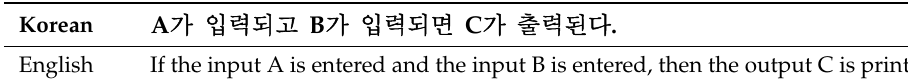
Table 2. A requirement sentence.